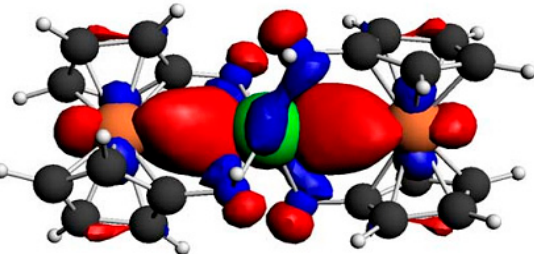
Figure 33. HOMO-5 of the Th(fc[NH] 2 ) 2 model cation. Green and magenta color for Th and Zr metals, respectively (reprinted with permission from [18], American Chemical Society, 2007).